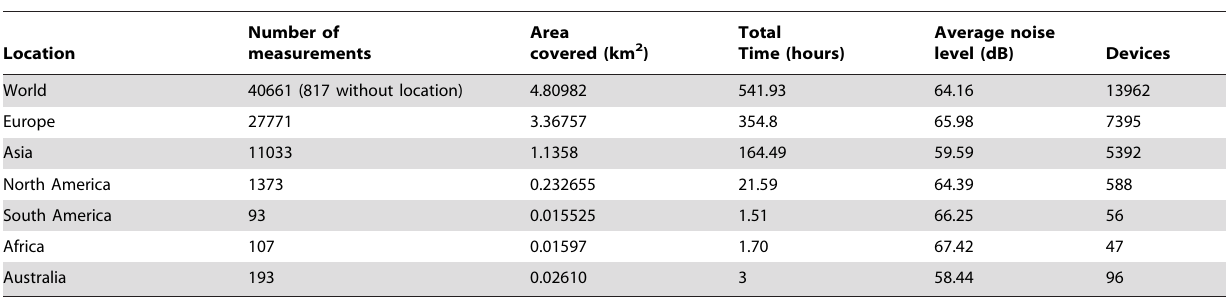
Table 1. General space and time